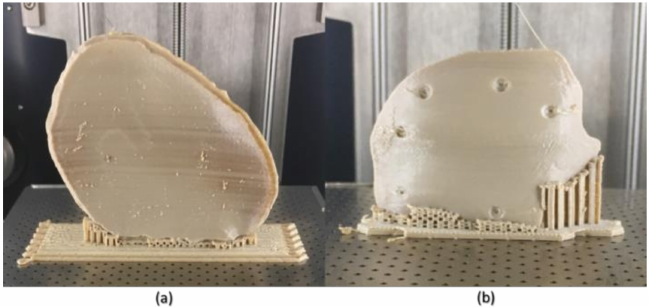
Figure 4. Fused filament fabrication (FFF) 3D printed polyetheretherketone (PEEK) cranial PSIs (in situ). ( a ) Group 1 PSI and ( b ) Group 2